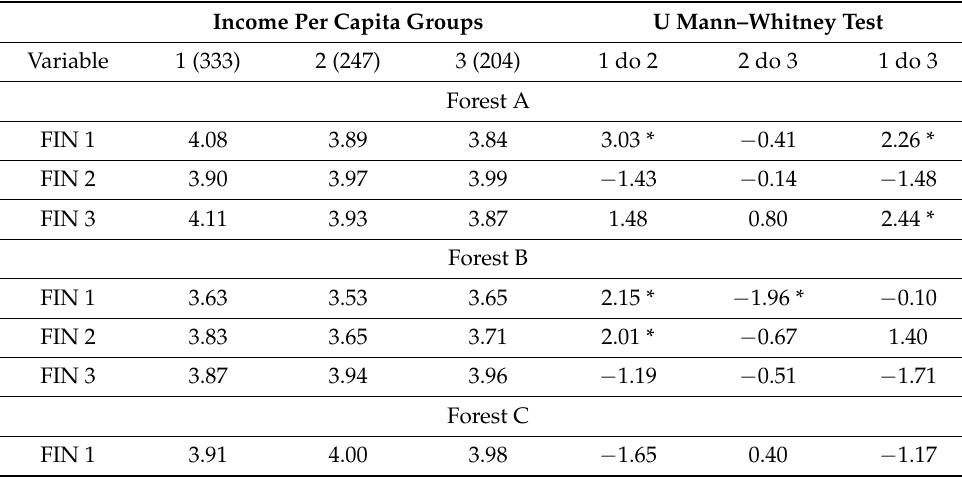
Table 8. WTP for a specific forest type in relation to the respondents’